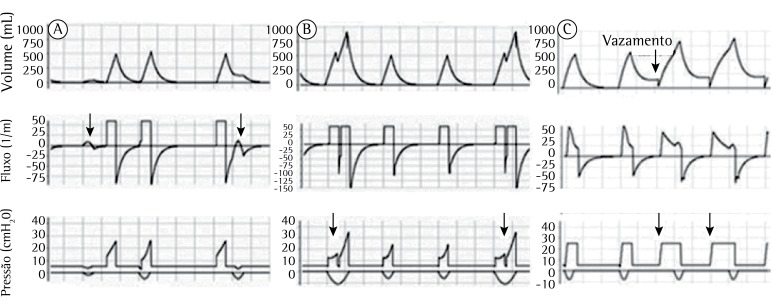
Assincronias de disparo identificadas nas curvas de volume, fluxo e
pressão versus tempo e assinaladas com setas. As deflexões negativas nas
curvas pressão versus tempo representam os esforços do paciente (pressão
muscular), visíveis somente se monitorizada a pressão esofágica. Painel
A) Esforços perdidos. Na primeira seta, observar um estímulo débil,
incapaz de disparar o ventilador, resultando em uma pequena onda de fluxo
positiva e em mínimo volume corrente. Na segunda seta, observar o esforço
que ocorre durante a exalação, sem disparar o ventilador, apenas fazendo
com que o fluxo volte à linha de base e até se tornar levemente positivo.
Painel B) Duplo disparo. Exemplo em volume controlado. Os esforços do
paciente permanecem no momento da ciclagem e, assim, disparam novo ciclo.
Os volumes se somam (empilhamento), e a pressão nas vias aéreas se eleva,
disparando muitas vezes o alarme de alta pressão. Painel C) Autodisparo:
na modalidade pressão de suporte, alguns ciclos são disparados sem
esforços do paciente, tendo sido favorecidos pela presença de vazamentos,
visíveis na curva volume versus tempo, a qual não retorna à linha de base
(medida do volume inspirado maior do que a do expirado). Figuras obtidas
pelo Xlung.net, simulador virtual de ventilação mecânica. Disponível em:
http//:www.xlung.net.